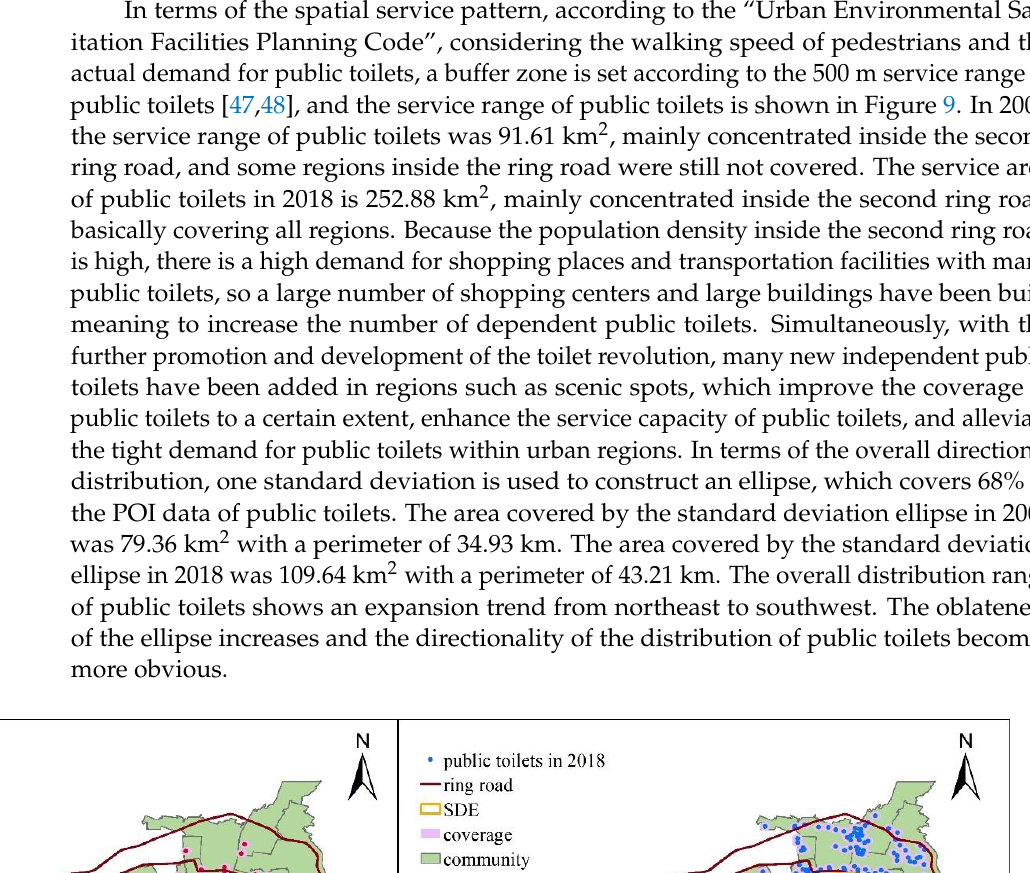
Table 2. Detailed list of POI data for seven categories.